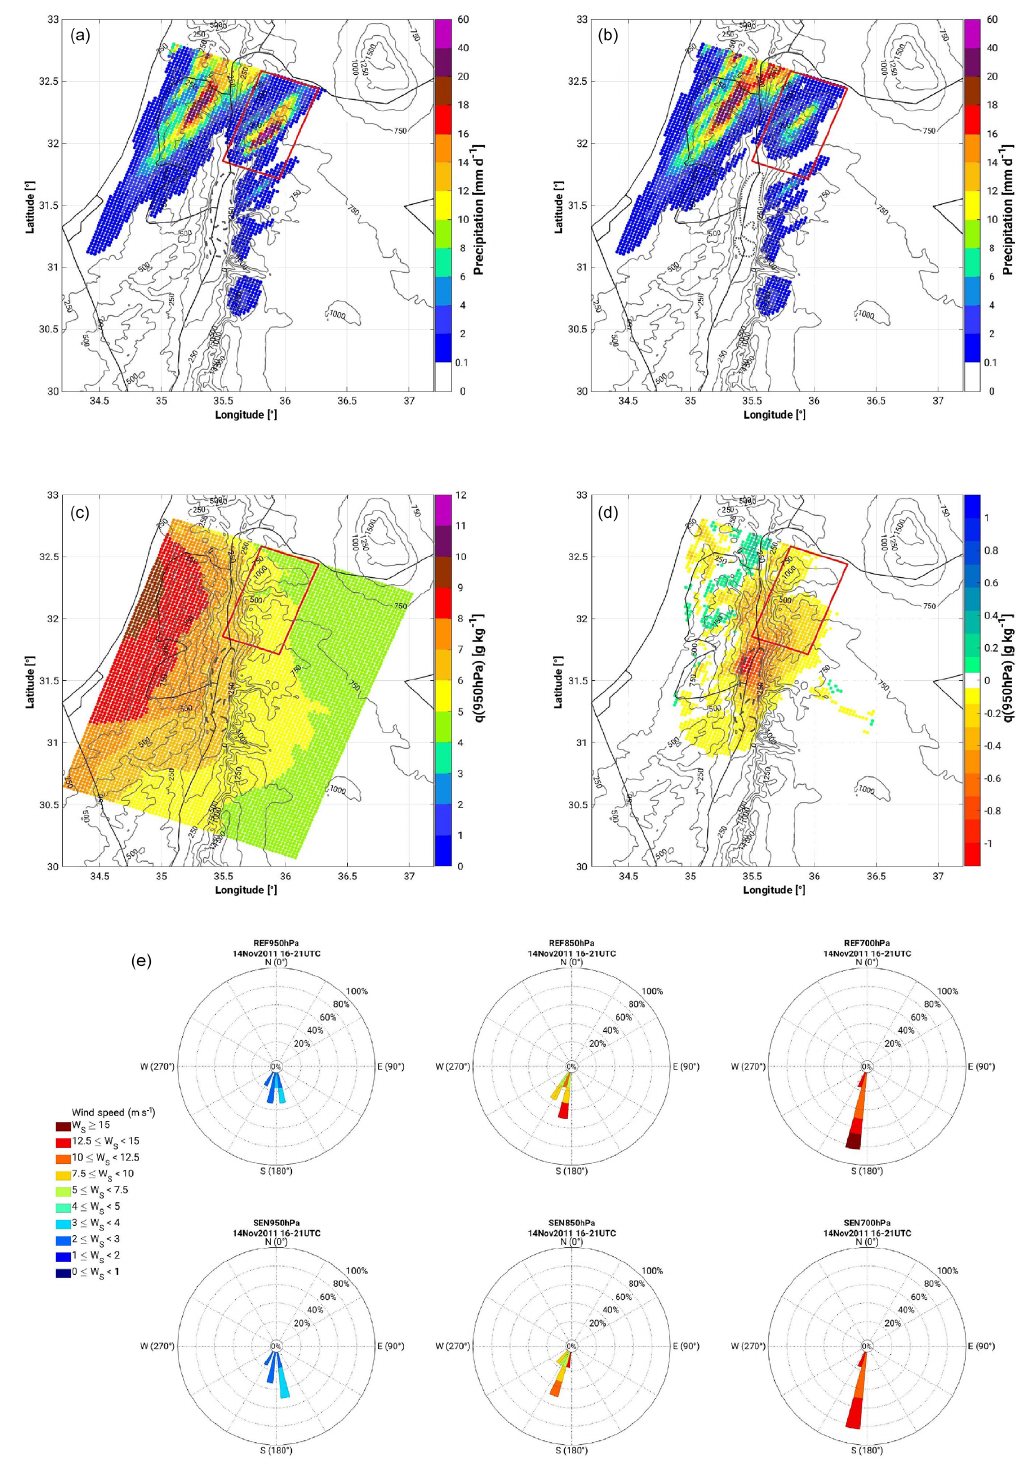
Figure 7. Spatial distribution of (a, b) 24h accumulated precipitation from 14 November 09:00UTC to 15 November 08:00UTC from the REF 14 . 11 simulation (a) and the SEN 14 . 11 simulation (b) . (c, d) Specific humidity below 950hPa from the REF 14 . 11 simulation (c) and the difference between the REF 14 . 11 and SEN 14 . 11 simulations (d) as a mean for the 6h period prior to the initiation of convection in the target area (14 November 16:00 to 21:00UTC). (e) Wind conditions at 700, 850 and 950hPa (no relevant differences with respect to the 10m field) for the same time period. Wind roses are centred at approximately 32.07 ◦ N, 35.82 ◦ E in our target